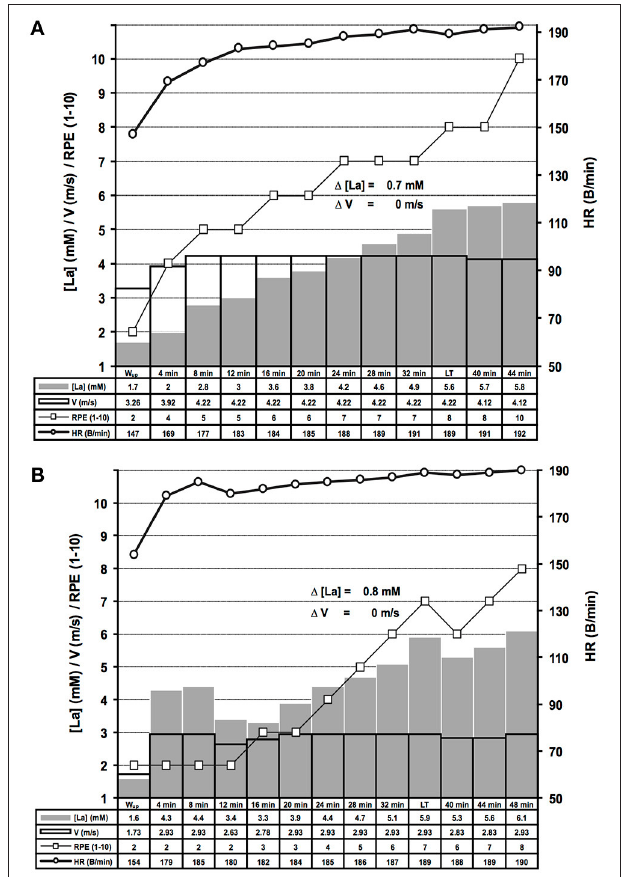
FIGURE 7 | Examples of distinct lactate kinetics near the maximal lactate steady state workload. (A) The lactate threshold (LT) appeared after 8 steps of unaltered workload (WL) (threshold criterion 2 (TC2), for rationale see Figure 1 ); (B) After a too high WL at the beginning of the test and subsequent correction, the LT was detected using TC2. HR, heart rate; [La], arterial lactate concentration; RPE, rating of perceived exertion; V, treadmill velocity. ( Figure 4A ). The mean day-to-day difference of the